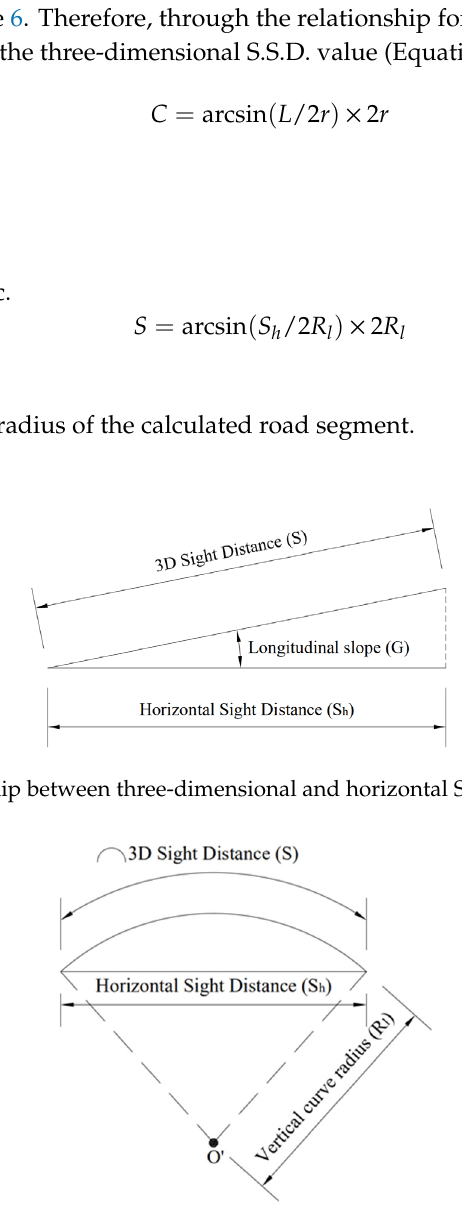
Figure 6. Relationship between three-dimensional parking line of sight and plane parking line of sight in vertical curve section.